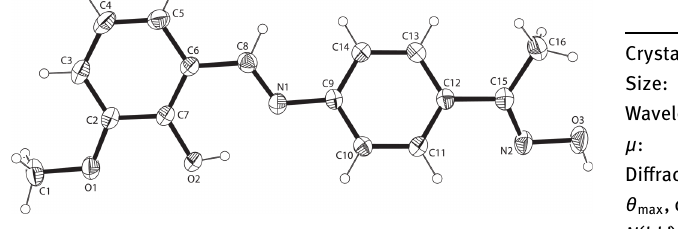
Table 1: Data collection and